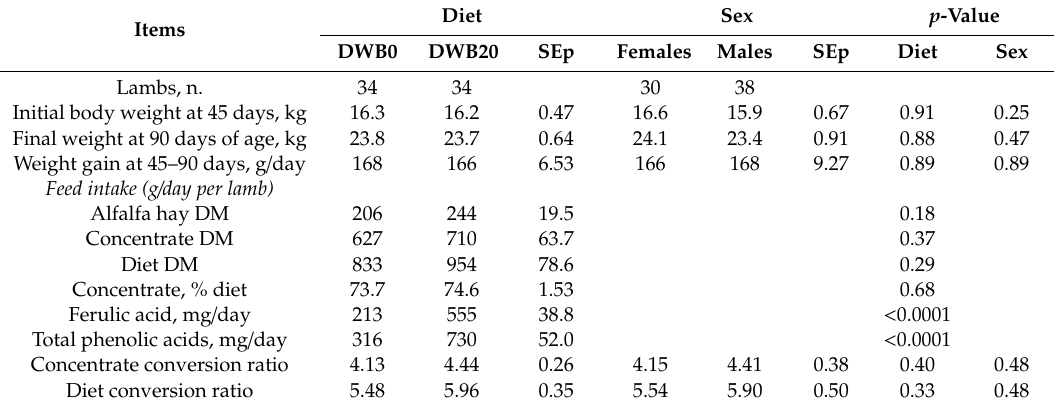
Table 2. Growth performance and feed intake of lambs from 45 to 90 days of